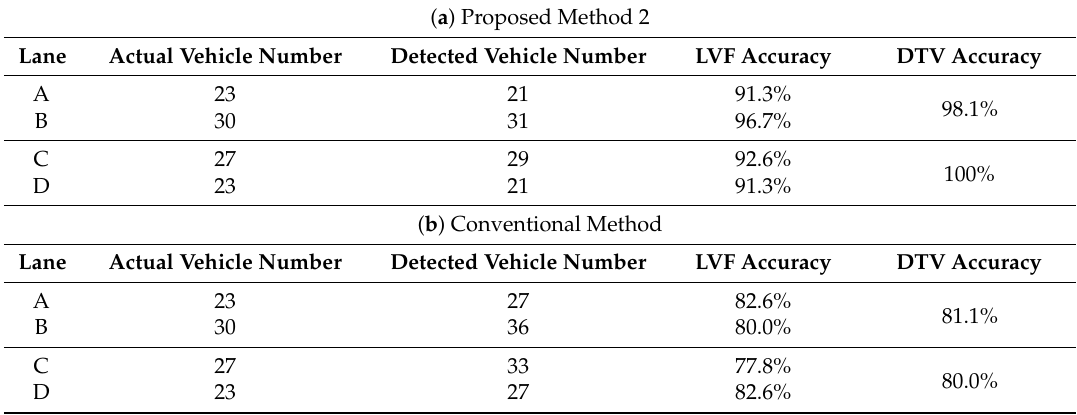
Table 1. Results of LVF (lane vehicle flow) and DTV (directional traffic volume) detection during 12:25–12:35 AM (light traffic) using ( a ) proposed method 2 and ( b ) conventional method.